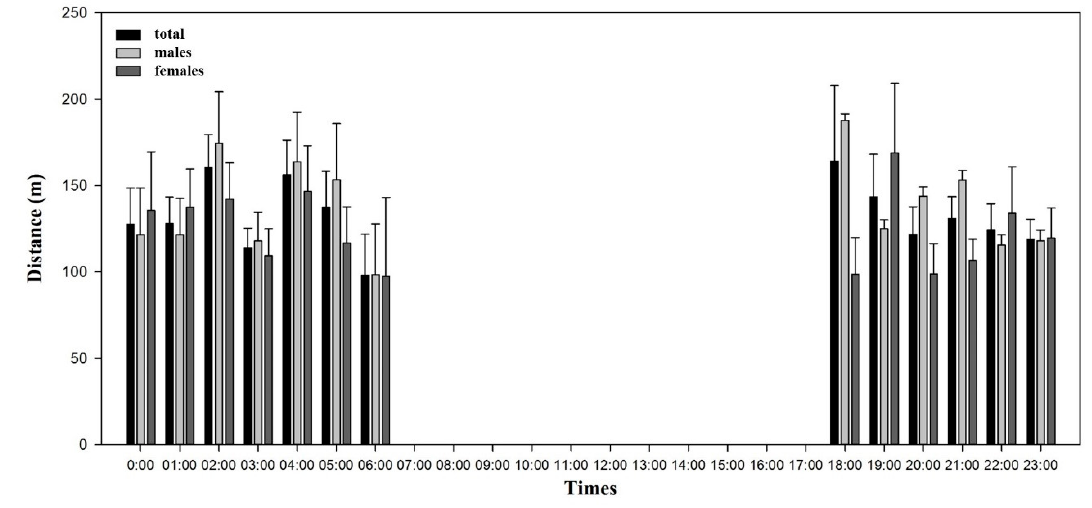
Figure 4. Daily movement of Siberian flying squirrels at Mt. Baekwoon, Gangwon Province, South Korea.